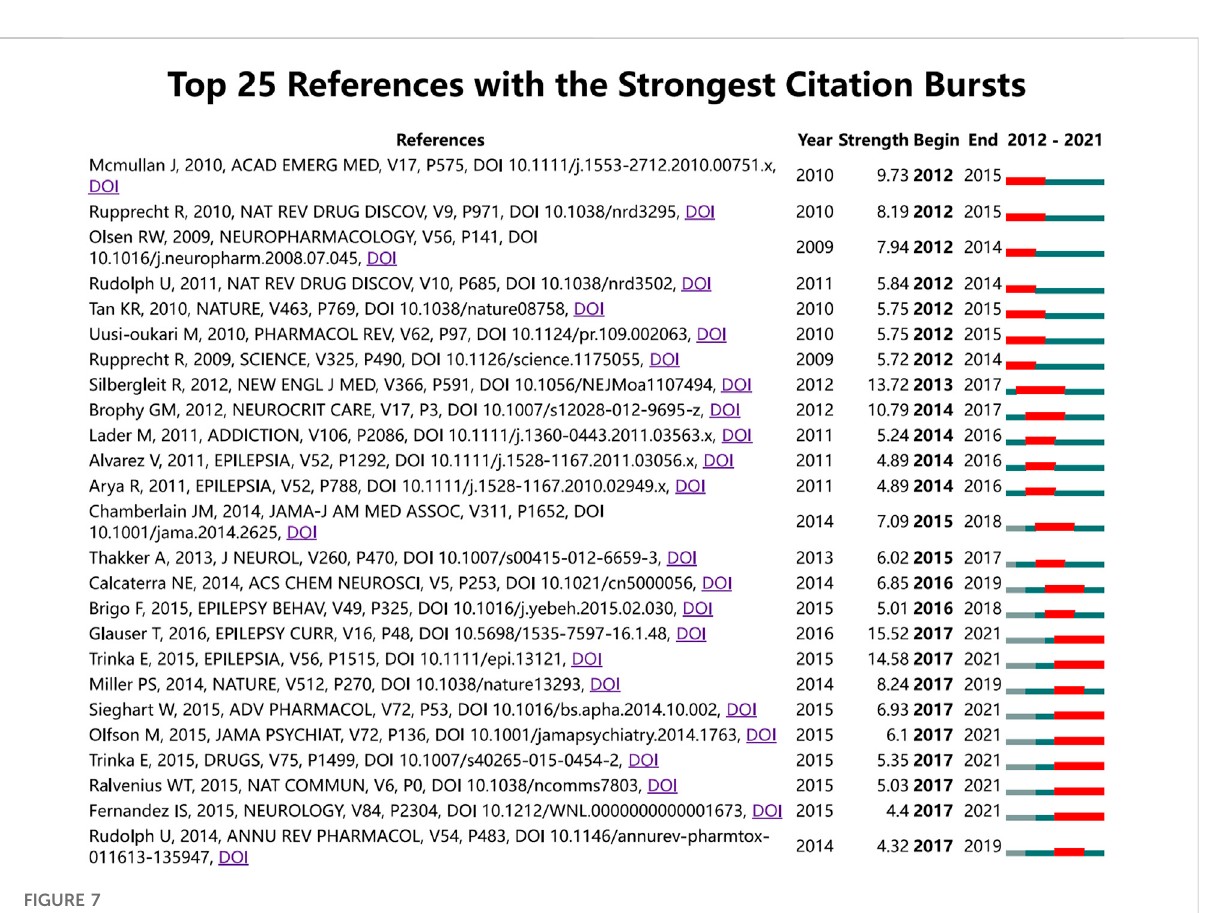
FIGURE 7 CiteSpacemapofthe25referencesofdiazepamresearchwiththestrongestcitationbursts.Note:thelightbluebarsre fl ecttheperiod,thesky- blue bars re fl ect the publication period, and the red bars re fl ect the duration of the